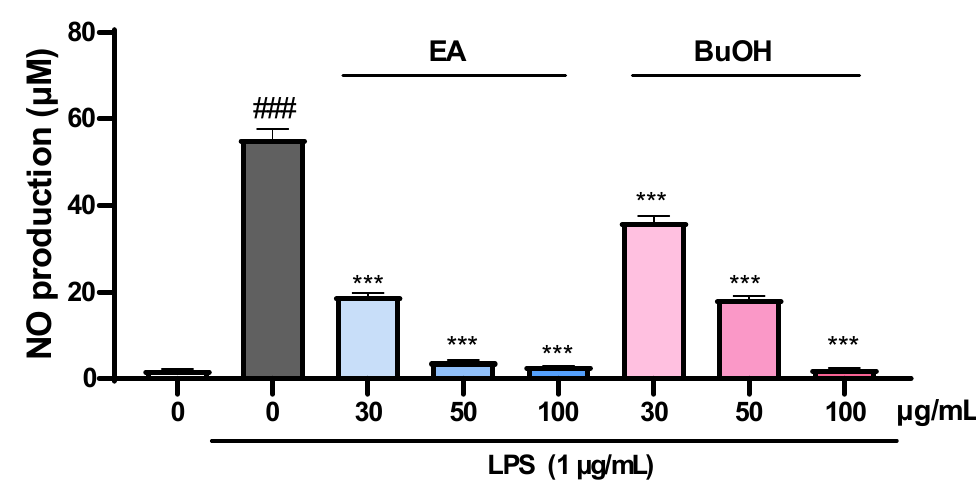
Figure 8. Inhibitory effect of ethyl acetate and butanol fractions of methanol extract of liverwort on NO production by LPS-stimulated HaCaT cells. EA, ethyl acetate fraction; BuOH, butanol fraction; Values are mean of three replicate determinations ( n = 3) ± standard deviation. ### p < 0.001 vs. 1% MeOH alone, *** p < 0.001 vs. LPS alone.